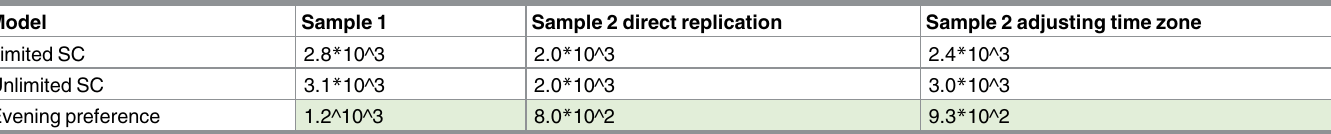
Table 3. Devianceof session length data from theoretical models of daily session length